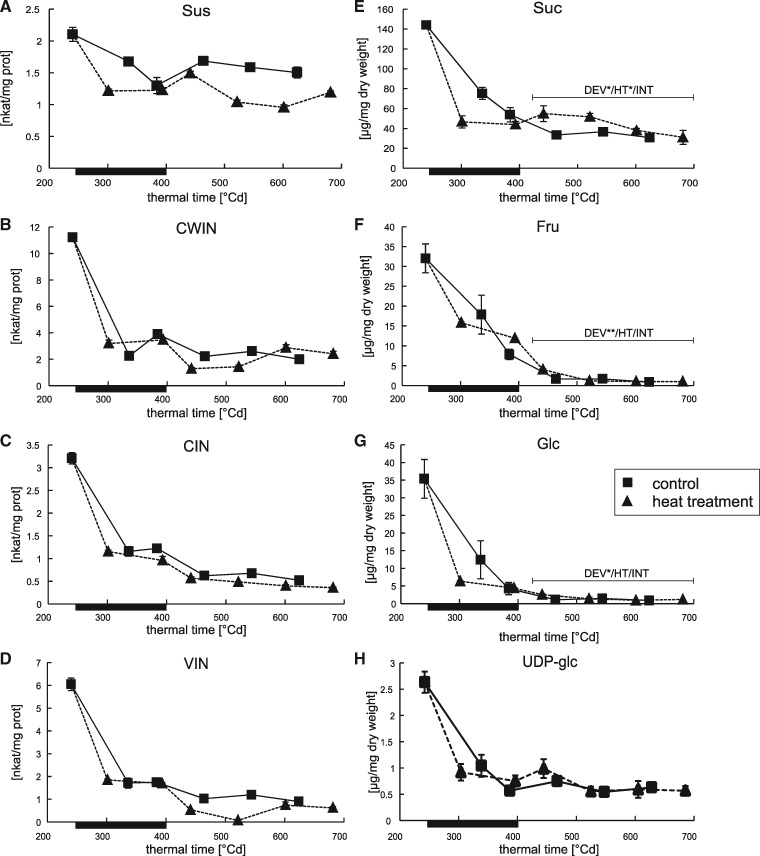
Time course analyses of the activity of sucrolytic enzymes and the content of their substrate and reaction products in the barley grain. Depicted is the phase of starch accumulation (starting with DAF 15, 240�Cd). The duration of the heat wave is indicated by a black bar on the abscissae of each graph. Squared symbols represent data points from plants grown under control conditions, while triangles represent plants that suffered from a heat wave between days 16 and 21 after anthesis. Time is shown as thermal time [�Cd] to facilitate comparison between the two curves shown. Enzyme activities are shown in nkat per mg protein on the left hand side for (A) SuS, (B) CWIN, (C) CIN and (D) VIN. For analysis, material from three biological replicates was pooled. Error bars represent � the standard deviation of three measurements of the combined sample. On the right hand side, the grain content of (E) Suc, (F) Fru, (G) Glc and (H) UDP-glc are shown in micrograms per milligram dry weight. The same samples as in (A–D) were used for analyses, but measurements were done on individual samples. Error bars represent � standard deviations between biological replicates, n = 3. The bars above the respective curves indicate ANCOVA analysis showing *P < 0.05 or **P < 0.01 significance. DEV, difference in sugar content over time of combined treatments; HT, difference in sugar content between treatments; INT, interaction between changes over the indicated thermal time period and the applied treatment.